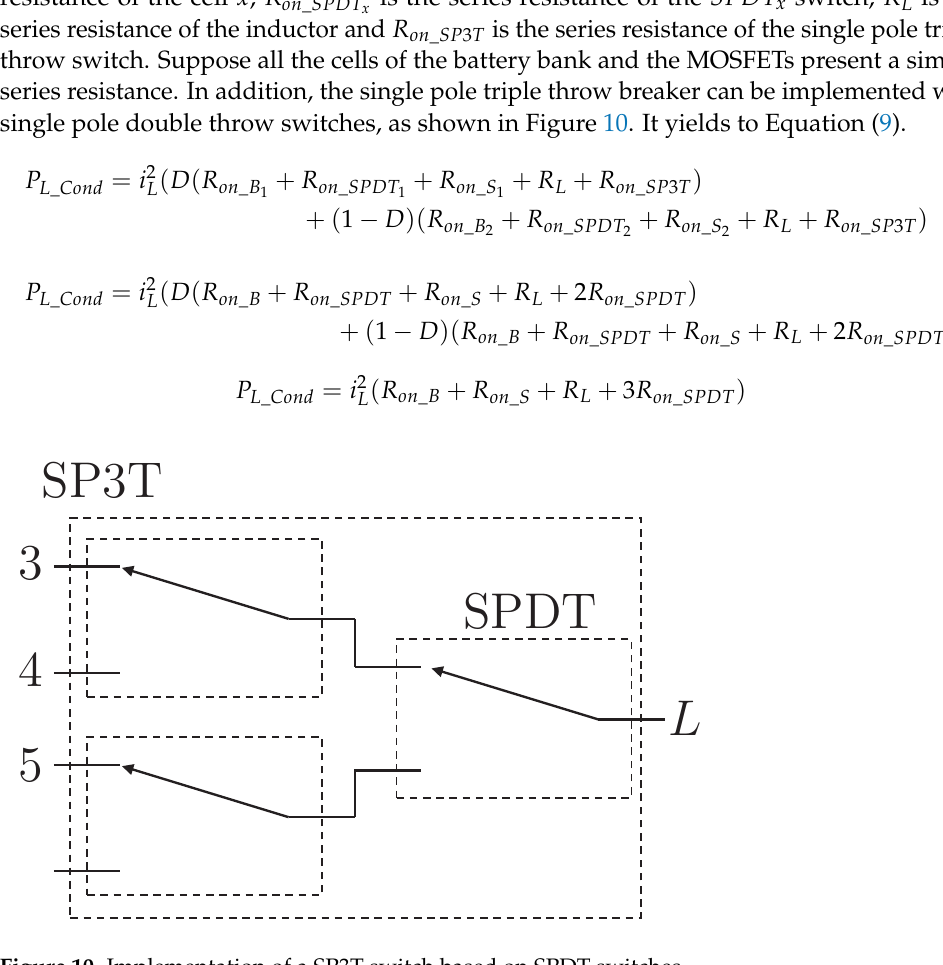
Figure 10. Implementation of a SP3T switch based on SPDT